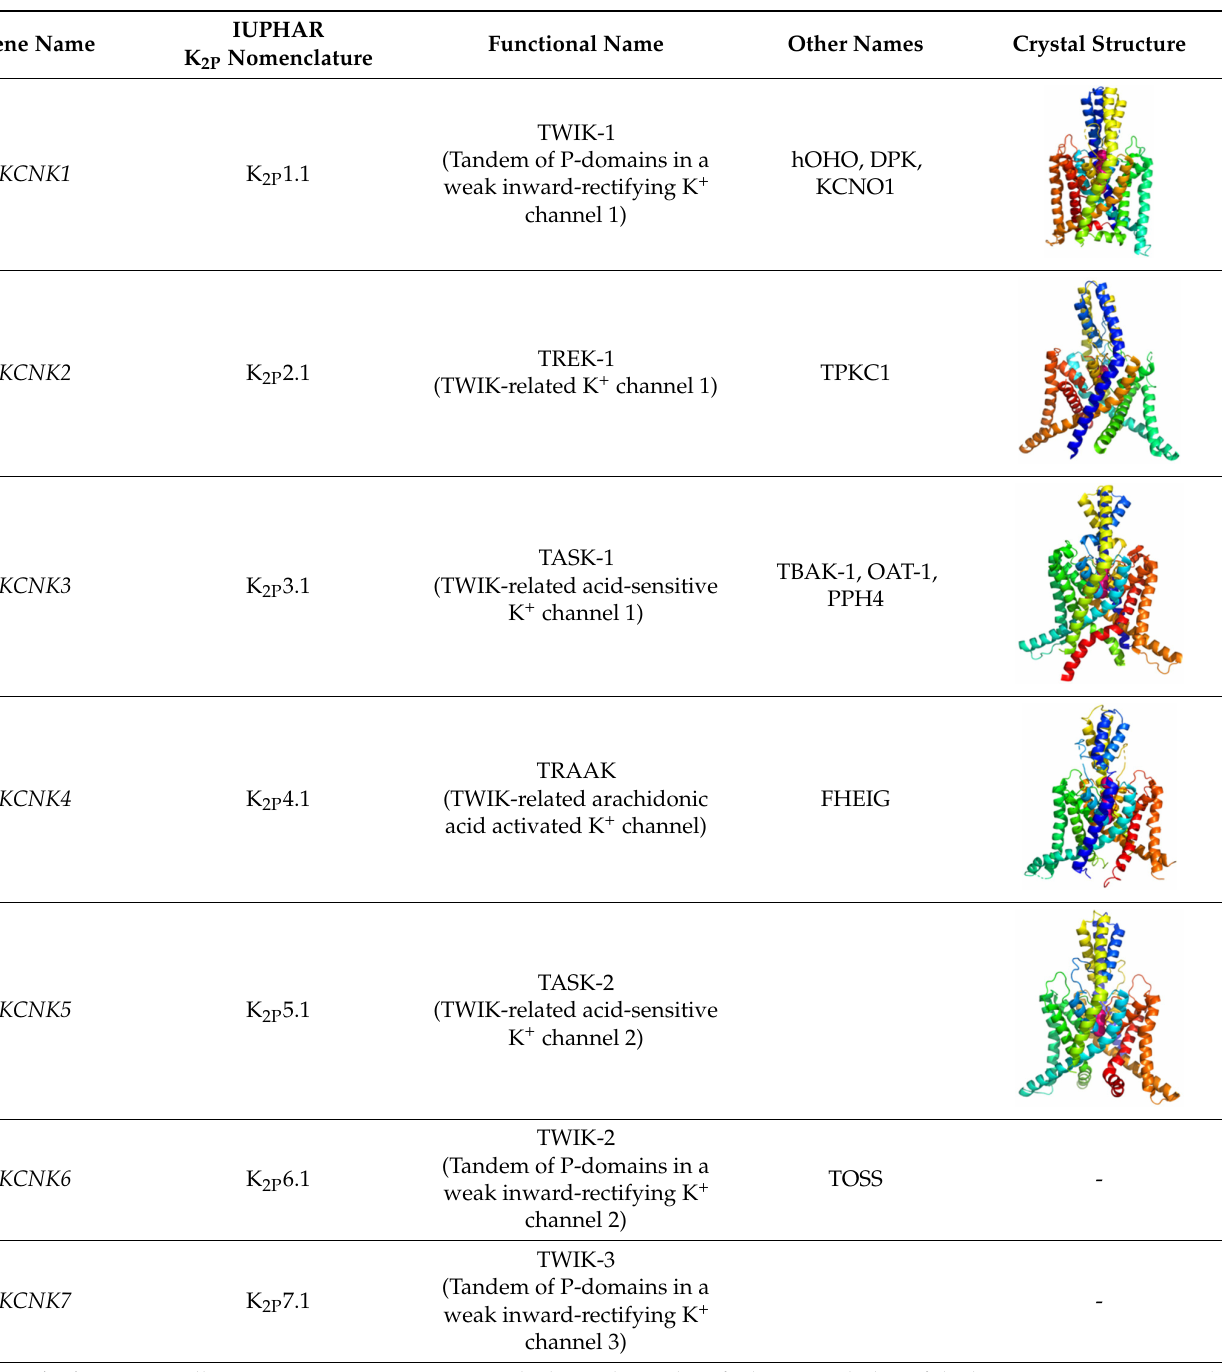
Table 1. Nomenclature of K 2P